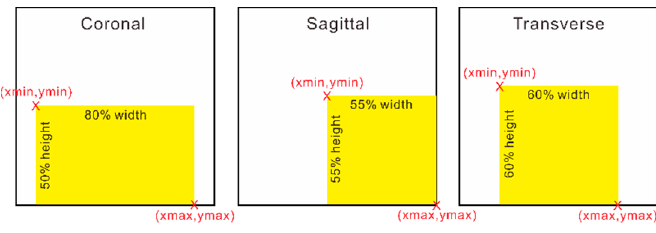
Figure 7. Region of interest (ROI) of the calcaneus based on the anatomical plane orientation.